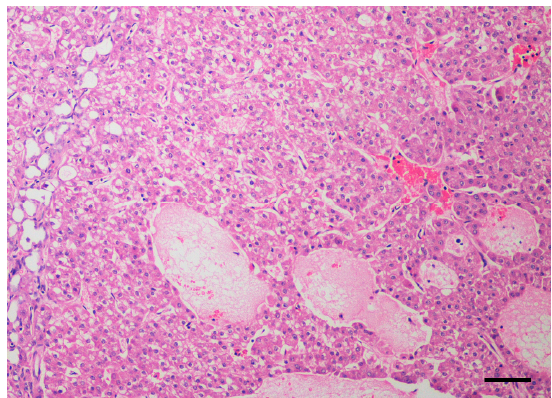
Figure 3. Dog, liver. Histological sample of hepatocellular carcinoma. The trabeculae of hepatocytes are separated by multiple irregular vascular channels and cavernous spaces. The cytoplasm of neoplastic cell is often pale staining or vacuolated due to glycogen or lipid filling. Multifocally, the neoplastic tissue is loss and replaced by granular eosinophilic and karyorrhectic debris (colliquative necrosis). Hematoxylin and eosin. Bar, 100 µm.